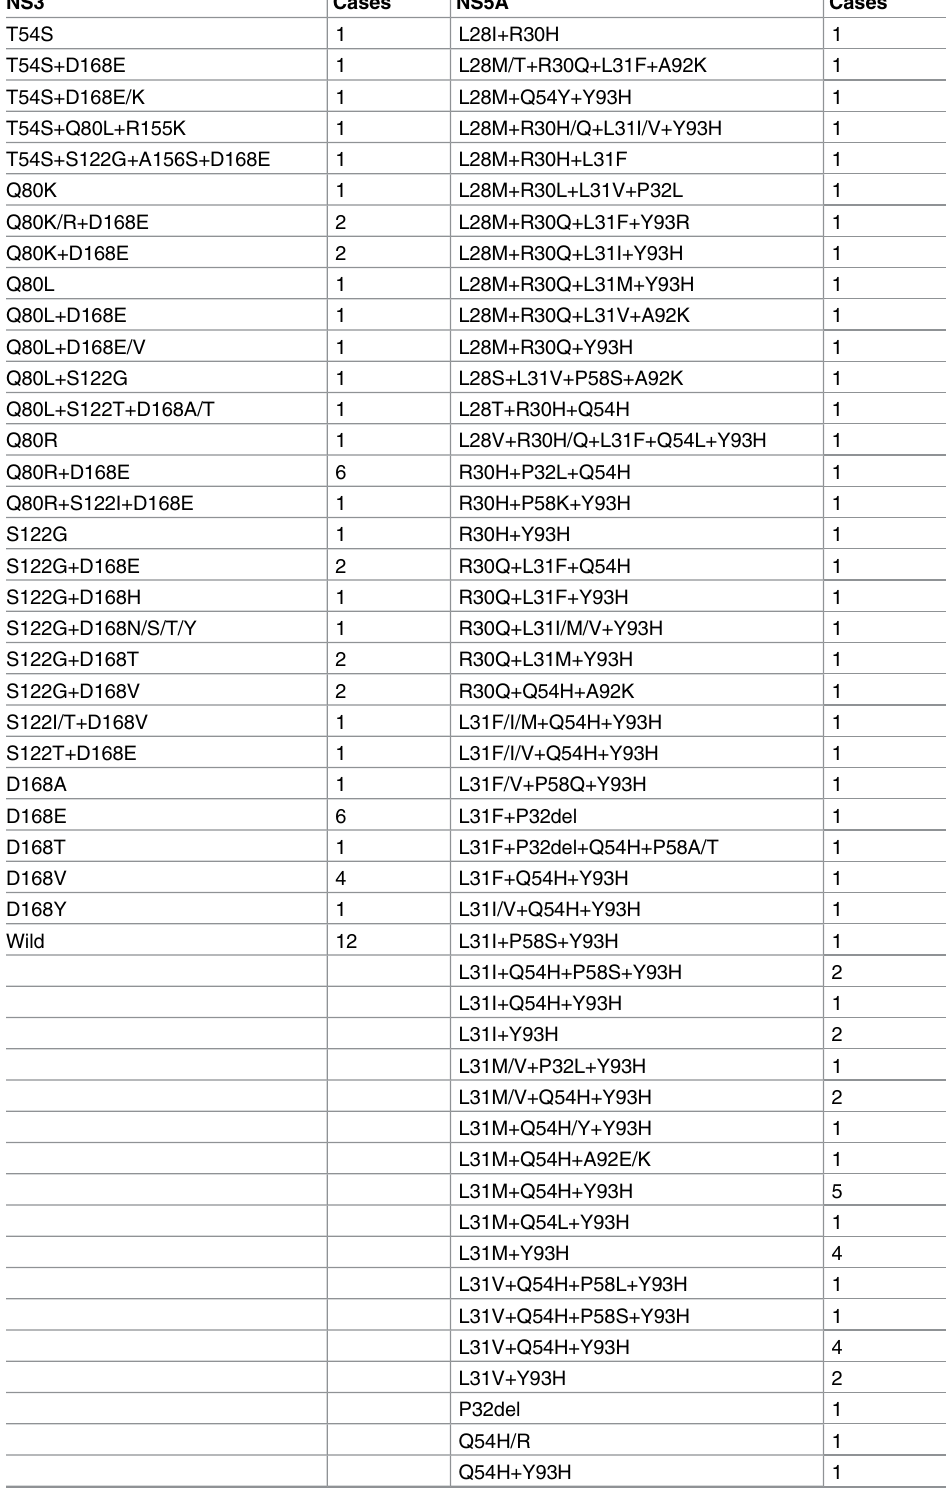
Table 2. RAS in NS3 and NS5A regions after failure of daclatasvir/asenaprevir combination